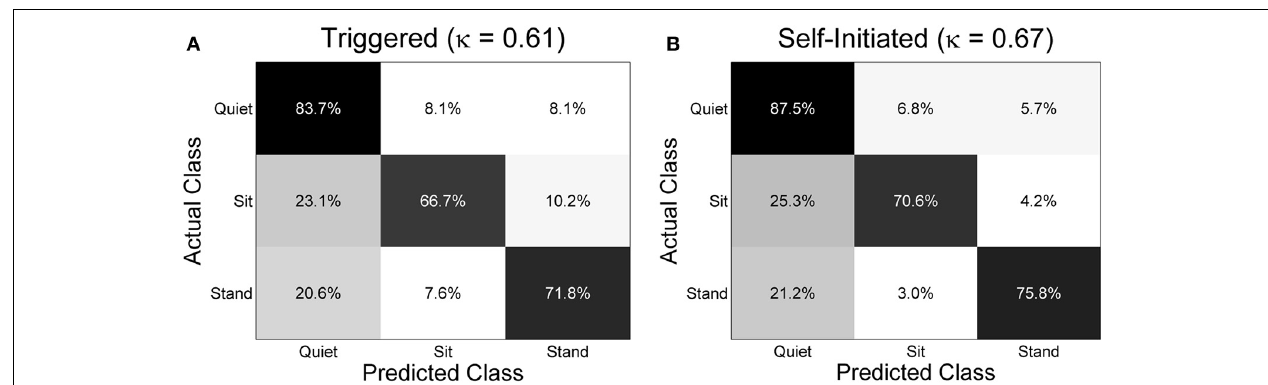
FIGURE 8 | Normalized confusion matrices across all subjects for the three class decoding problem for (A) triggered and (B) self-initiated conditions. The confusion matrices were computed by totaling the predicted number of samples from each class across all 10 subjects